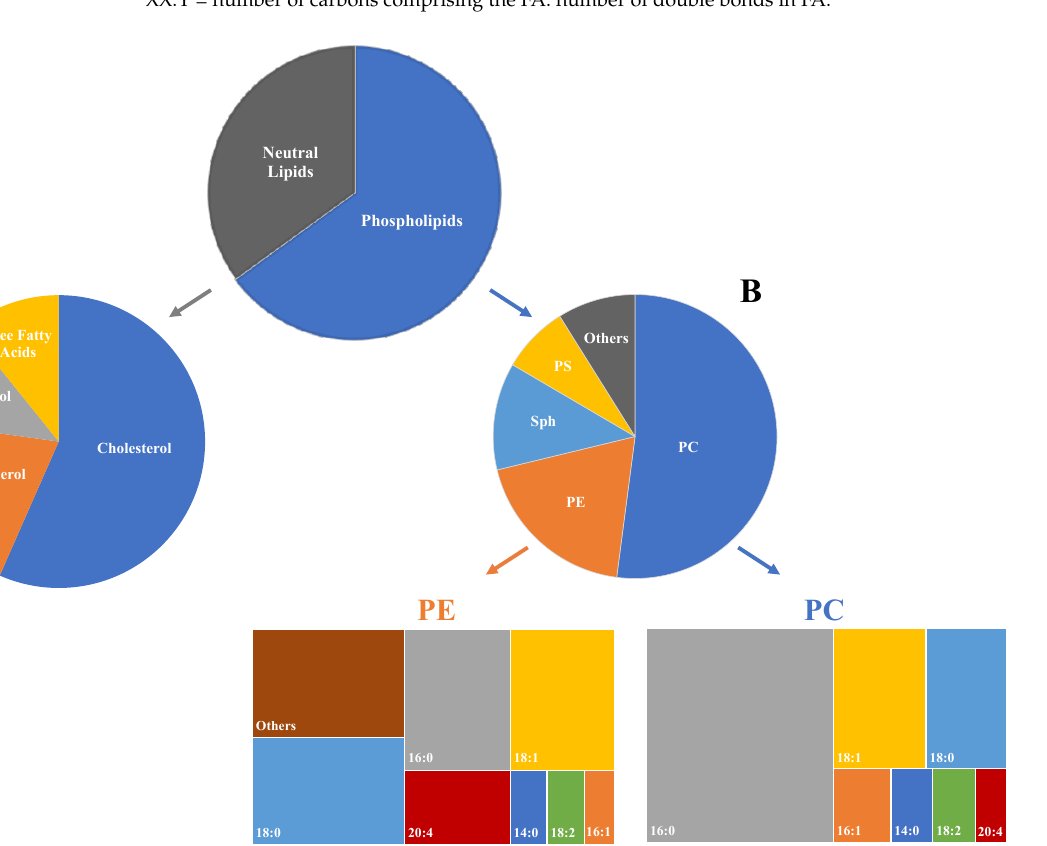
Table 1. Commonly reported FAs in lung tissue and lung surfactant [16,21] .